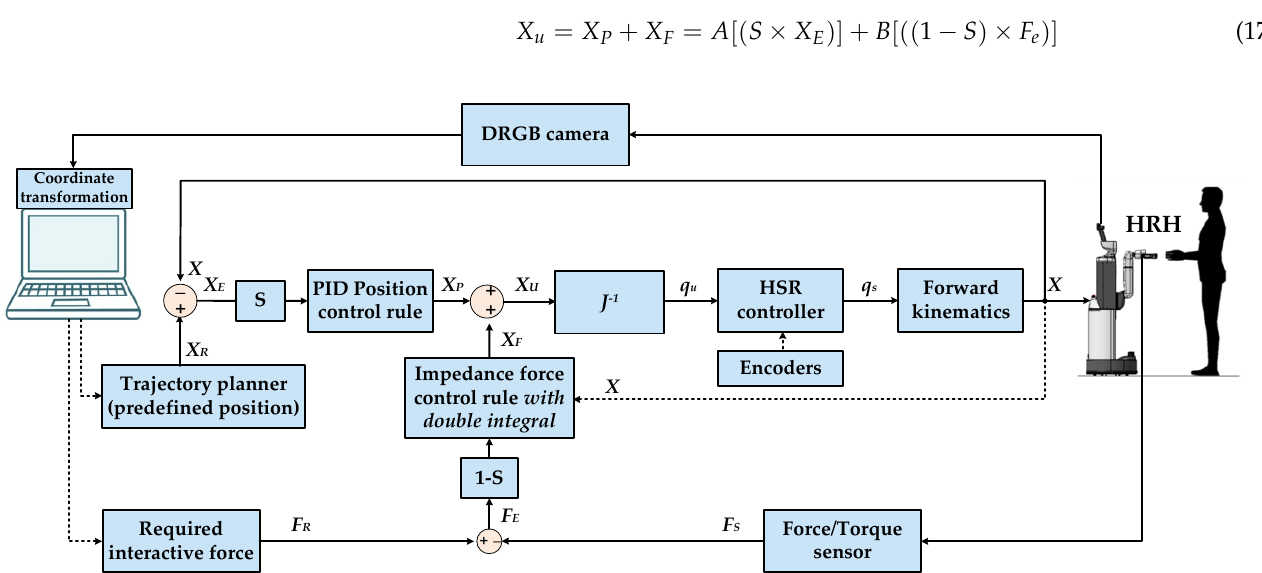
Figure 5. Hybrid PID position/impedance force control designed for the HSR in the HRH tasks. The positions of the robot in joint space ( 𝑞 𝑢 ) can be computed based on an inverse Jacobian matrix as expressed in the following equation.